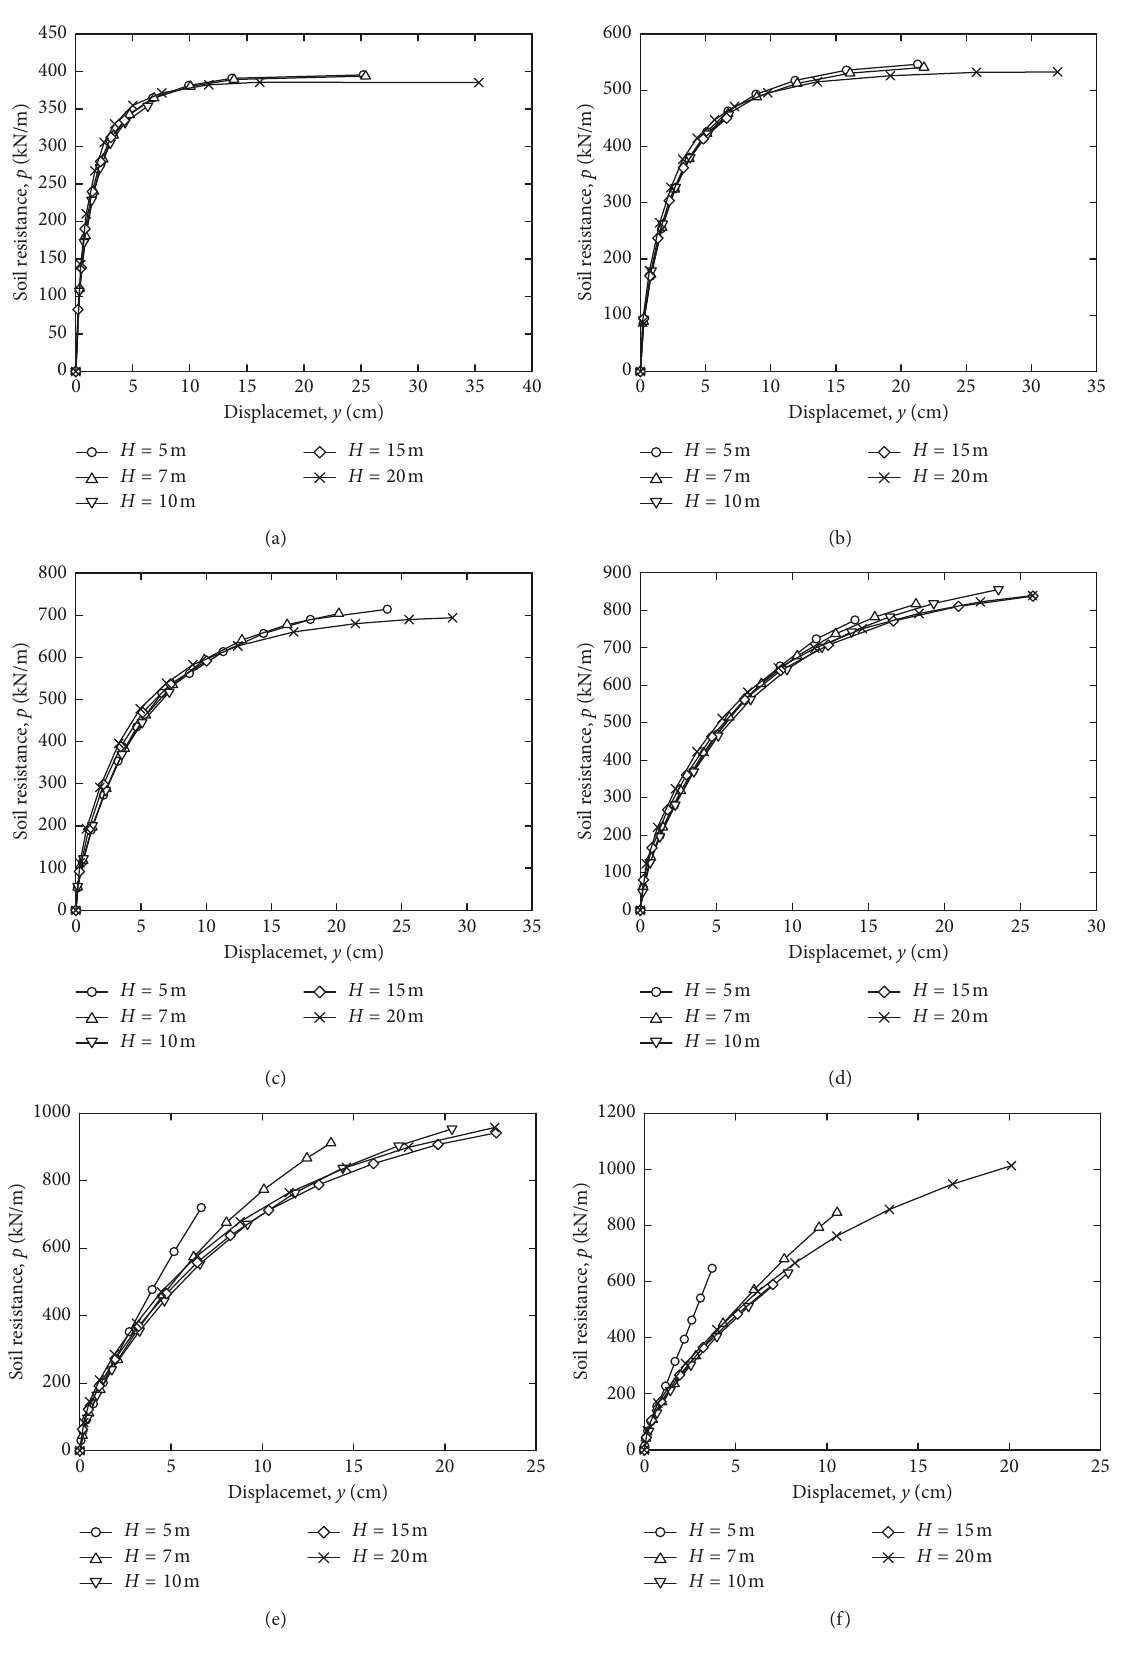
Figure 9: p - y curves of sands at depths of (a) 2.0 m, (b) 2.5m, (c) 3.0m, (d) 3.5m, (e) 4.0 m, and (f) 4.5m with different bedrock